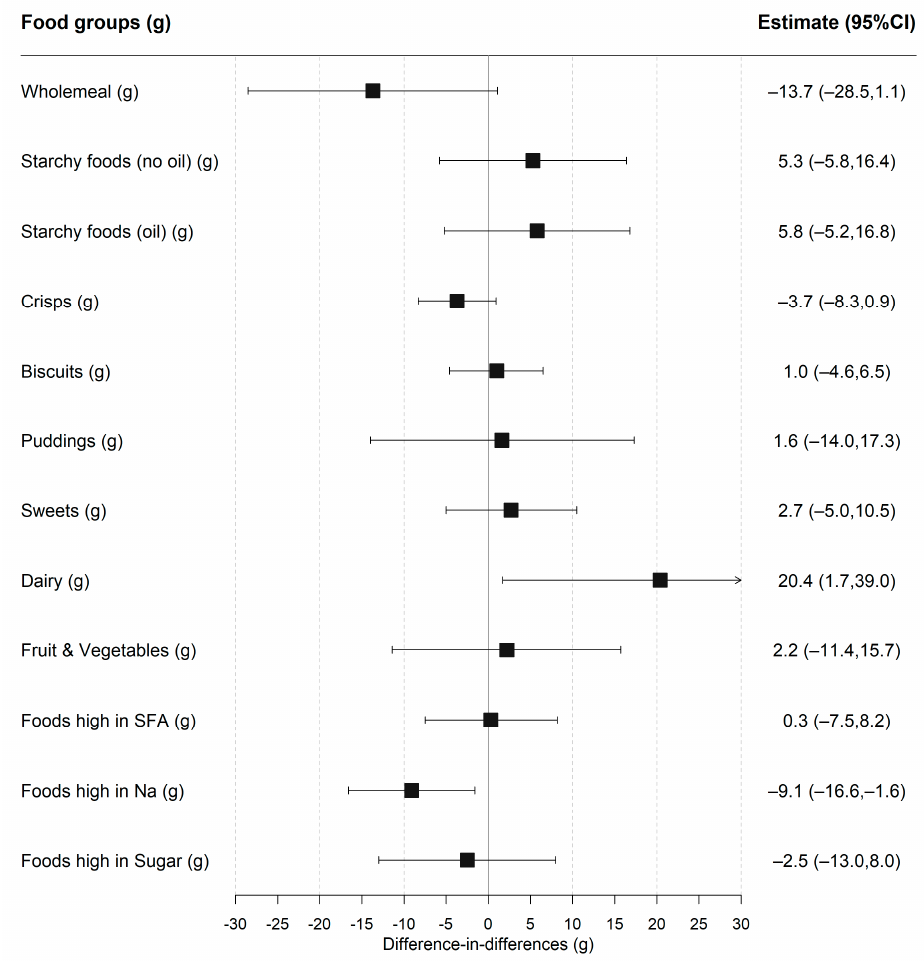
Figure 2. Difference-in-differences estimates of UIFSM policy impact on food groups consumed (g), conditional on consumption. Note: SFA—saturated fats; Na—sodium. Linear regression adjusted for age, sex, ethnicity, household size, region, household income, IMD and total lunchtime intake. Coefficients compare the amount of a food group consumed, conditional on consumption (>0 g). Pre/Post mean intakes of food groups presented in Table